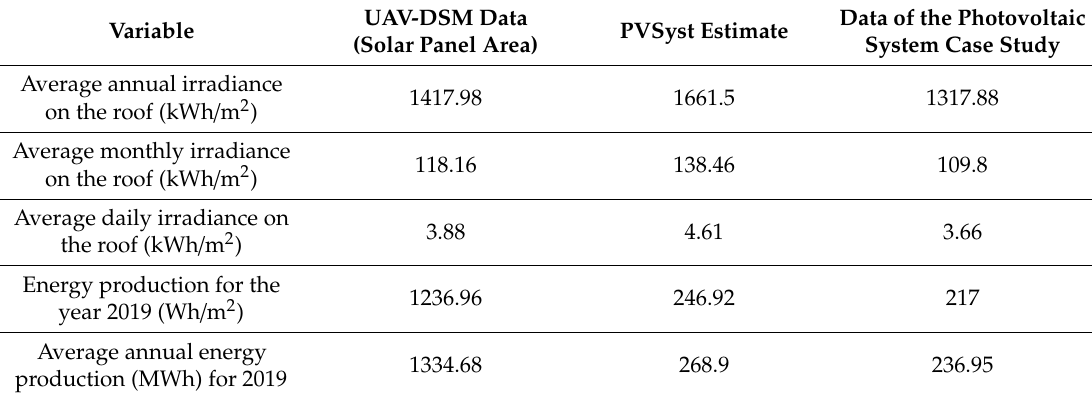
Table 3. Di ff erences in the variables related to the calculations of solar irradiance from UAV data, PVSyst estimate and solar